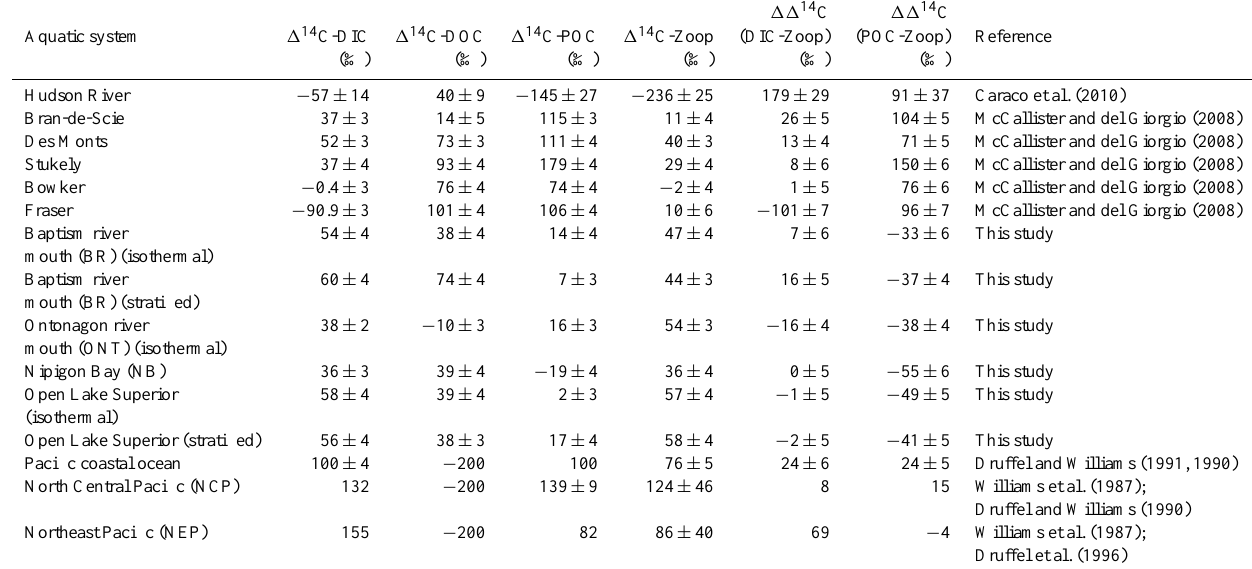
Table 6. Comparison of the radiocarbon signatures of DIC, DOC, POC, and zooplankton in small-to-large surface area aquatic systems. The open Lake Superior values are the averages of all the open lake sites during isothermal condition and during